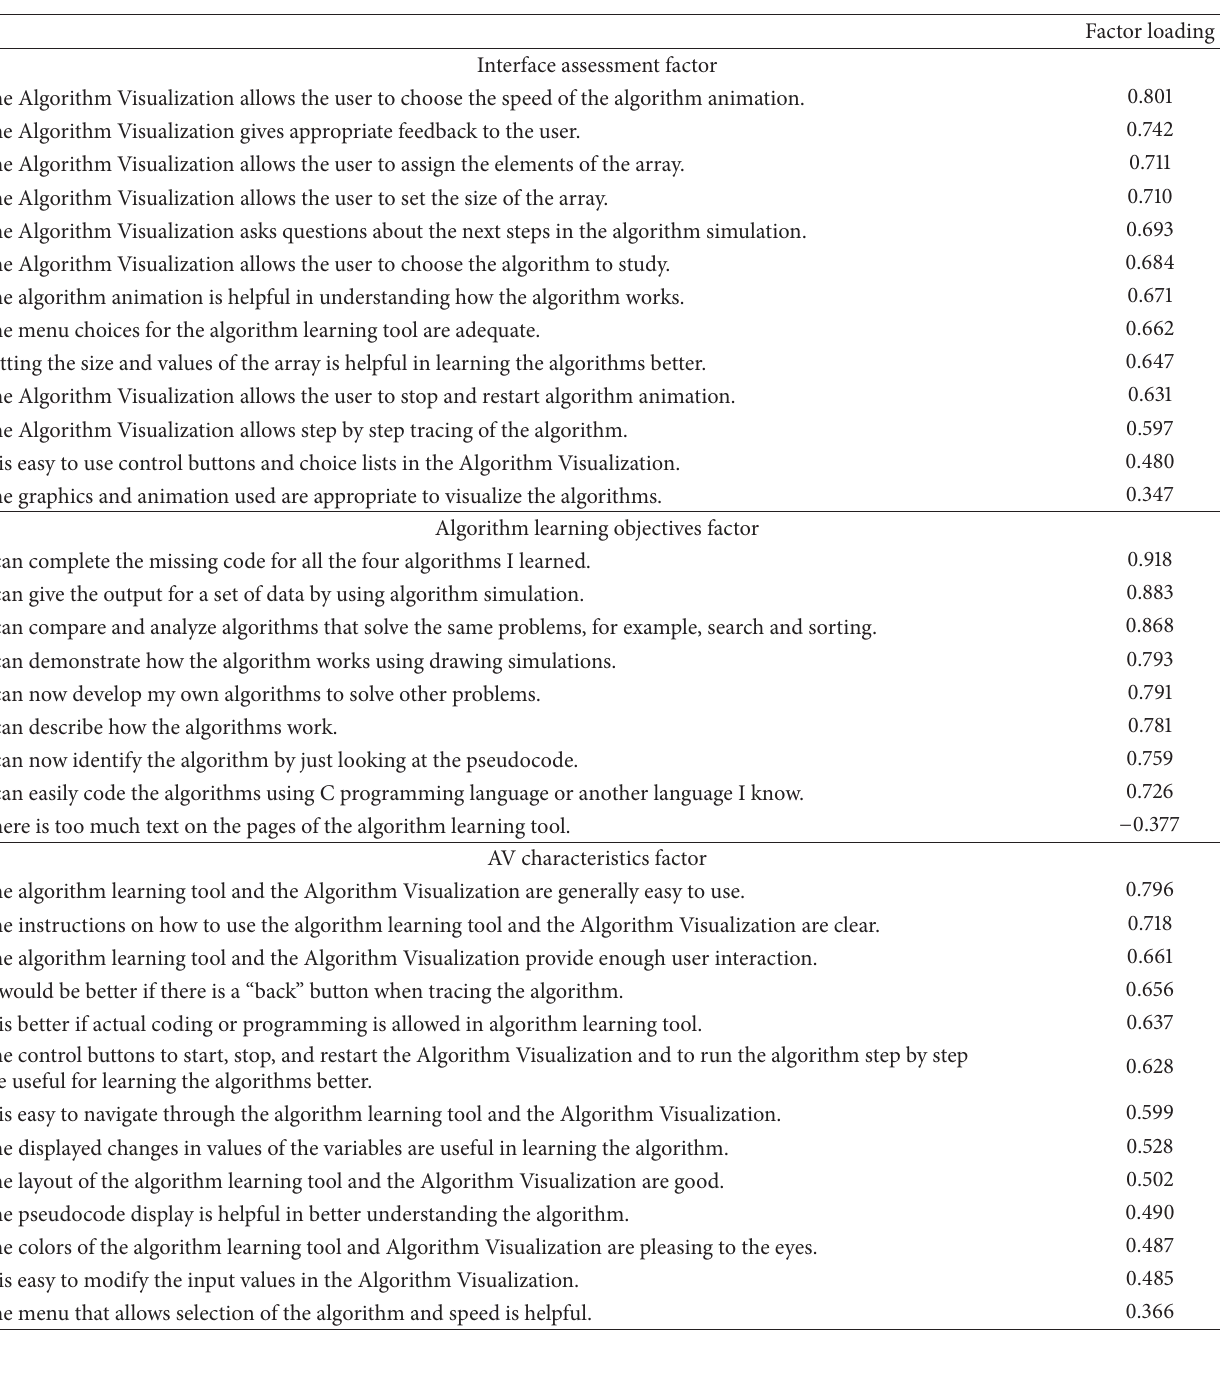
Table 5: Factor analysis of the evaluation